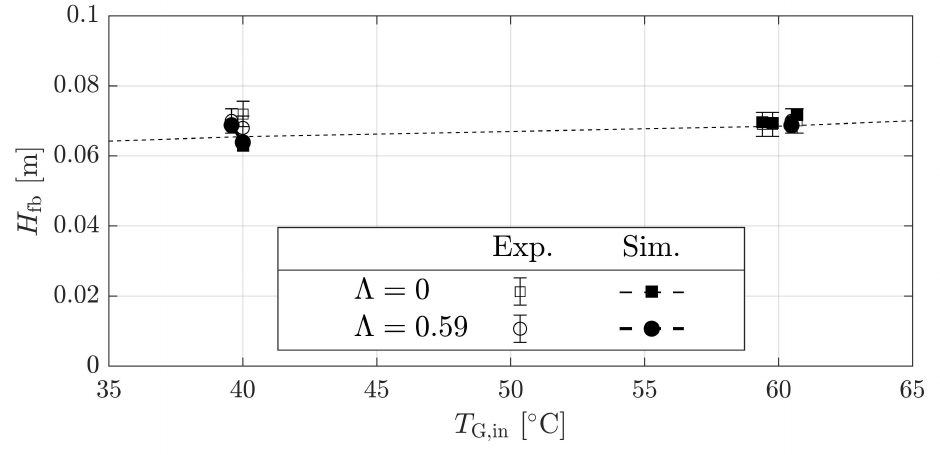
Figure 11. Comparison of bed height ( H fb ), measured in the VFB pilot-plant-scale dryer and model predictions for Cellets at an outflow hole height of